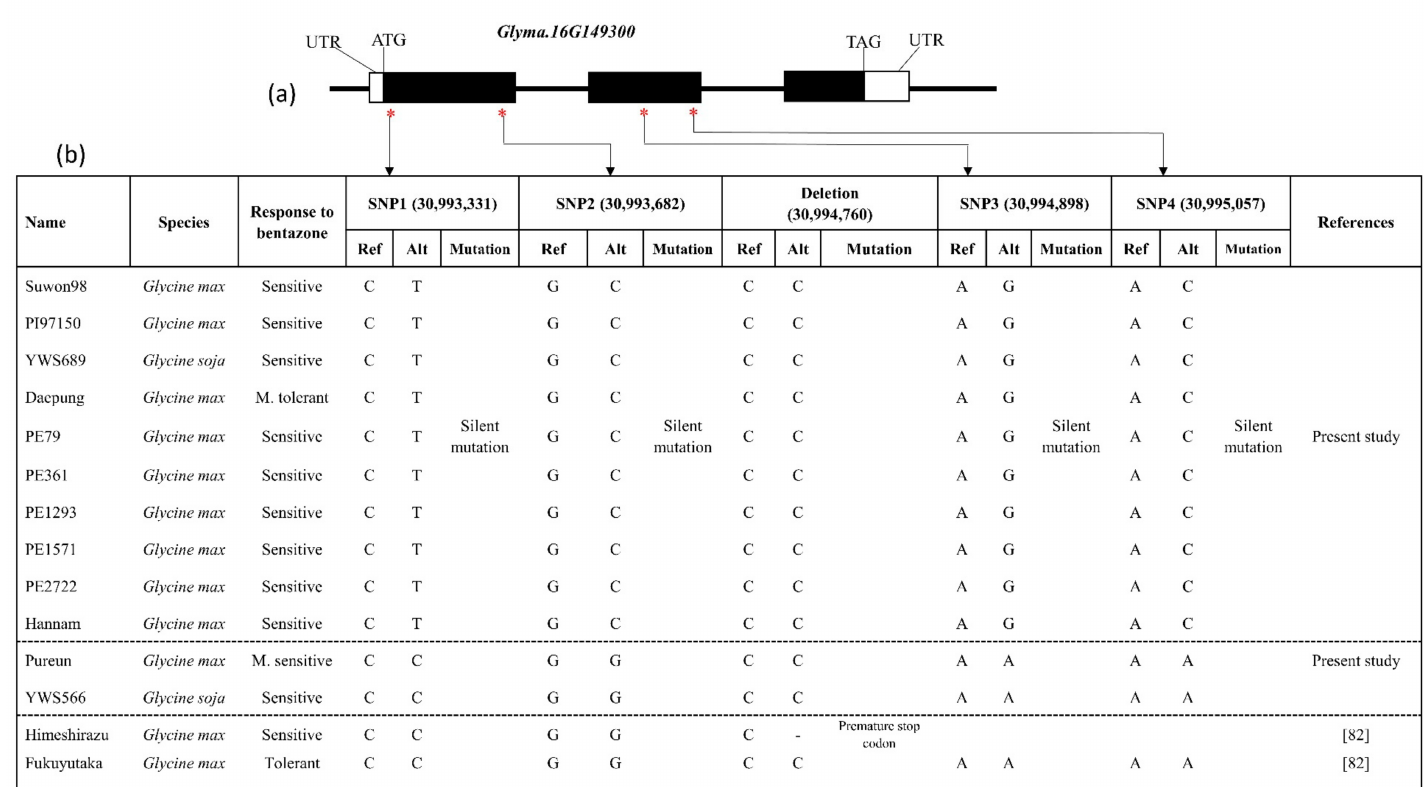
Figure 1. Four single nucleotide polymorphisms (SNPs) in exon 1 and 2 for soybean genotypes with bentazone susceptible. ( a ) gene model of Glyma.16G149300 where black boxes indicate exon regions, white box indicates untranslated region and black lines indicates intron region. Single nucleotide polymorphism in the exon region is marked with a red asterisk. ( b ) Bentazone response for selected soybean lines, and their SNP information for SNP positions. Daepung, Hannam, and Puren are Korean soybean cultivars [113], PEs were from ethyl methanesulfonate (EMS) mutagenesis of “Pungsannamul”, “Suwon98” and “PI97150” are germplasms. YWS689 and YWS566 are wild soybean germplasms. Kato et al. [76] identified that a single-base deletion was observed in the coding region of Glyma.16G149300 at physical position 30,994,760, resulting premature stop codon. Digits in parenthesis indicates physical position of SNP in soybean genome. Ref; reference SNP on W82.a2.V1, Alt;